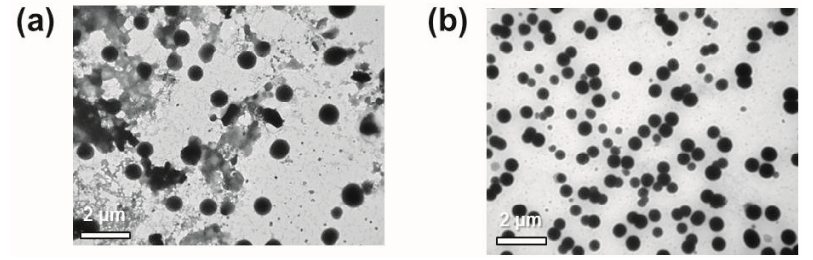
Figure 5. A comparison of TEM images with different focusing steps: ( a ) flow focusing without the retarding inlet channel; ( b ) flow focusing with the retarding inlet channel.